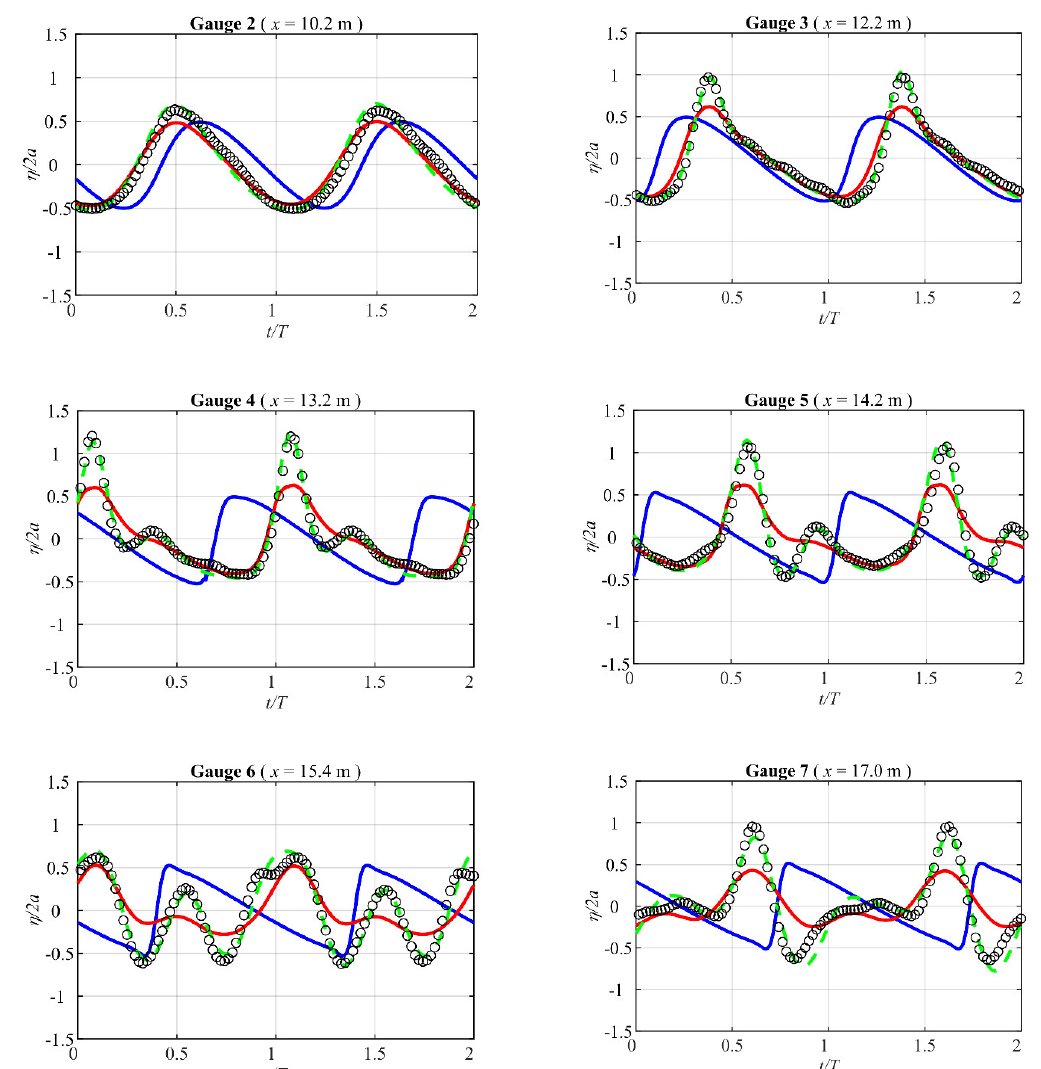
Figure 4. Comparison of computed free-surface elevation (blue lines denote the prediction of hydrostatic shallow-water model (SWM), red lines non-hydrostatic SWM) with measurement data (circles) and 5 δ -layers of non-hydrostatic SWM of [29,49] (green lines) at gauge 2 to gauge 7.